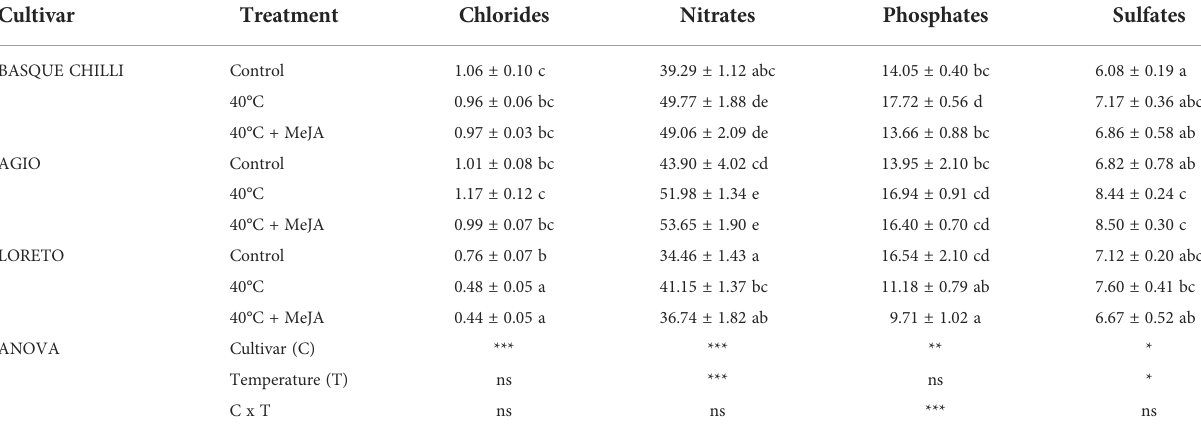
TABLE 1 Effects of heat shock and MeJA on leaf anion concentration (g kg -1 DW) of the three pepper cultivars. Cultivar